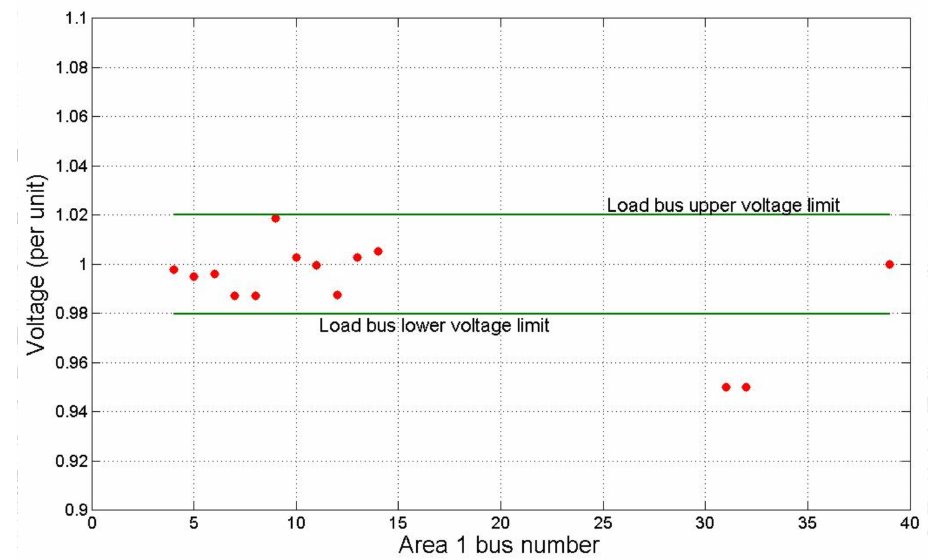
Figure 7. Distributed control: base voltage for decoupled area 1.